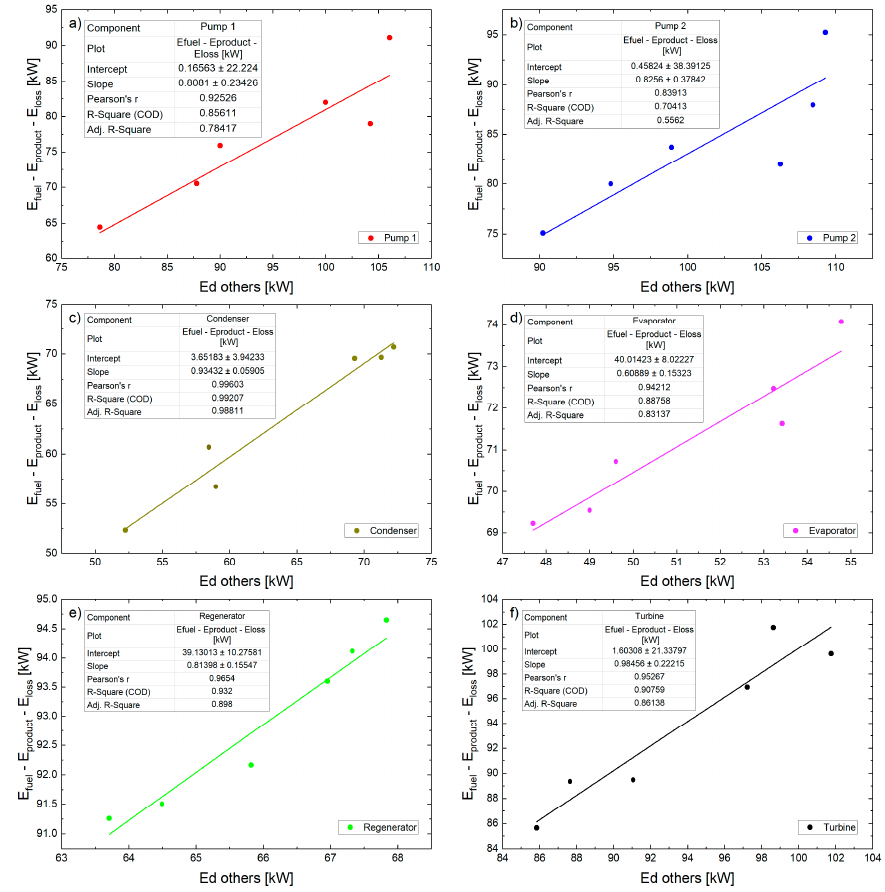
Figure 11. Exergy destroyed endogenously for ( a ) Pump 1; ( b ) Pump 2; ( c ) Condenser; ( d ) Evaporator; ( e ) Regenerator; and ( f ) Turbine.